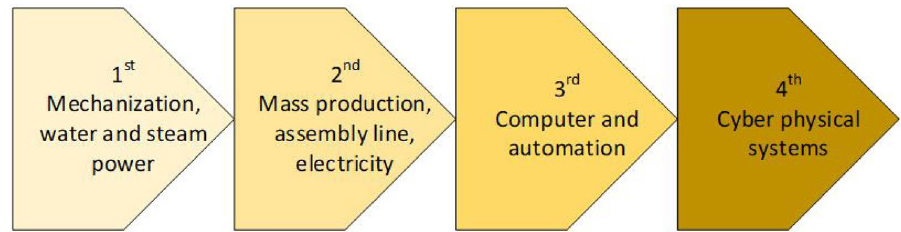
Fig. 3 Industry 4.0